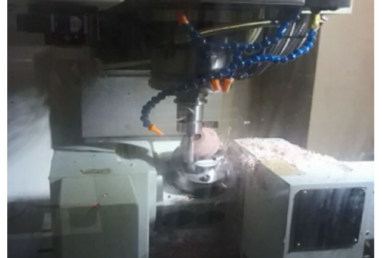
Figure 9. A snapshot during the five-axis machining.